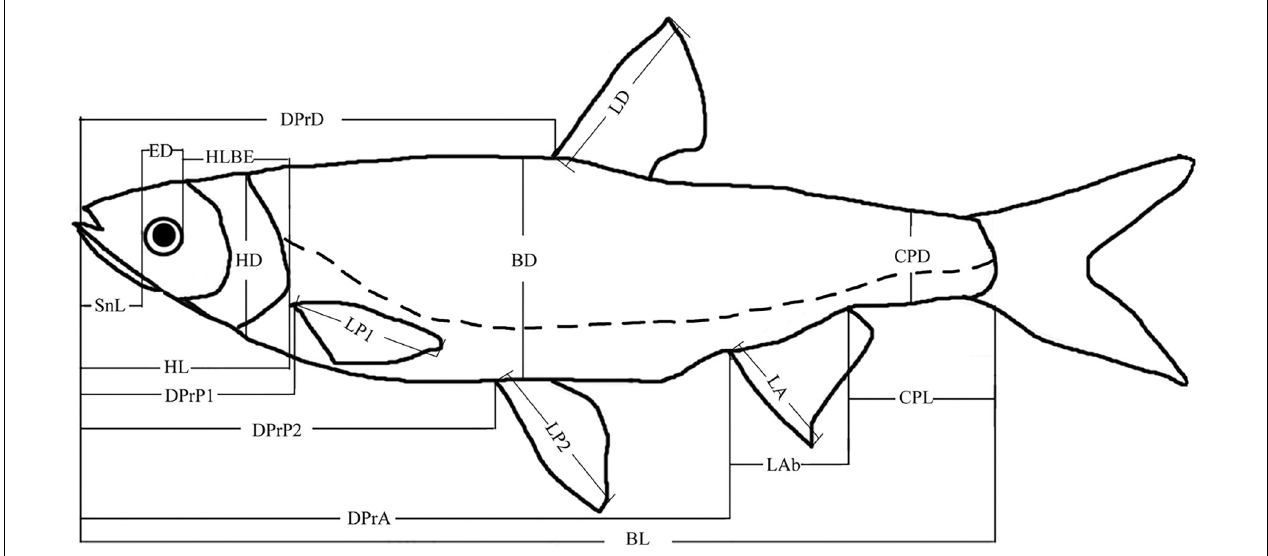
FIGURE 2 | Morphometric parameters investigated on H. leucisculus. BL, body length; BD, body depth; HL, head length; HD, head depth; SnL, snout length; ED, eye diameter; HLBE, head length behind eye; CPL, caudal peduncle length; CPD, caudal peduncle depth; DprD, predorsal fin distance; DPrP1, prepectoral fin distance; P1, pectoral fin; DPrP2, prepelvic fin distance; P2, pelvic fin; DPrA, pre-anal fin distance; BW, body width; EDs, eye distance; CPW, caudal peduncle width; LD, dorsal fin length; LP1, pectoral fin length; LP2, pelvic fin length; LA, anal fin